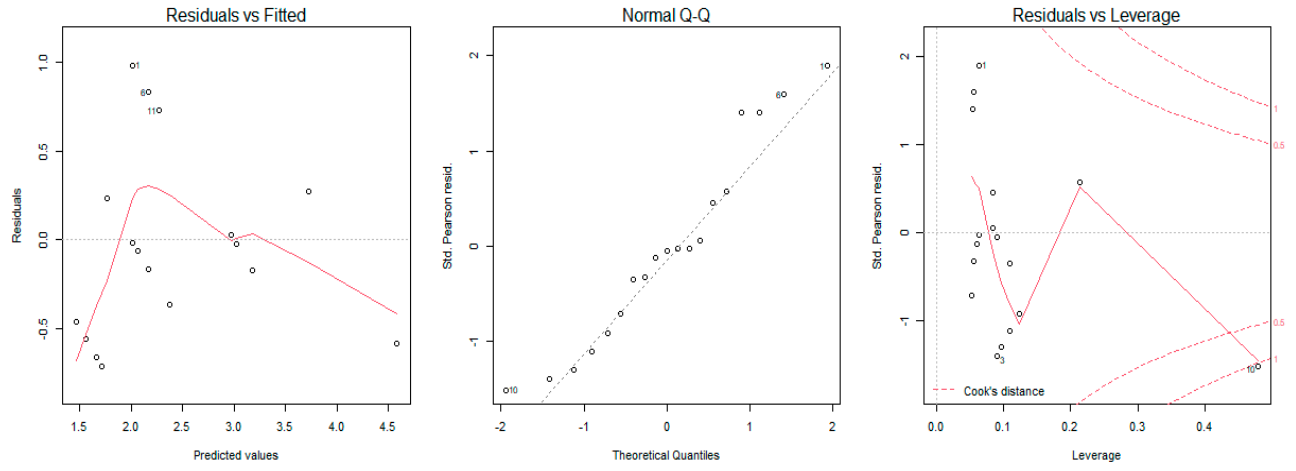
Figure 4. Graphical analysis of residuals for the MRC and Dynamometry model for Biceps Brachii muscle. The plot on the left shows the residual errors versus their estimated values; the QQ-plot in the center shows the distributive normality of the residuals; the plot on the right identifies any influential data points on the model.